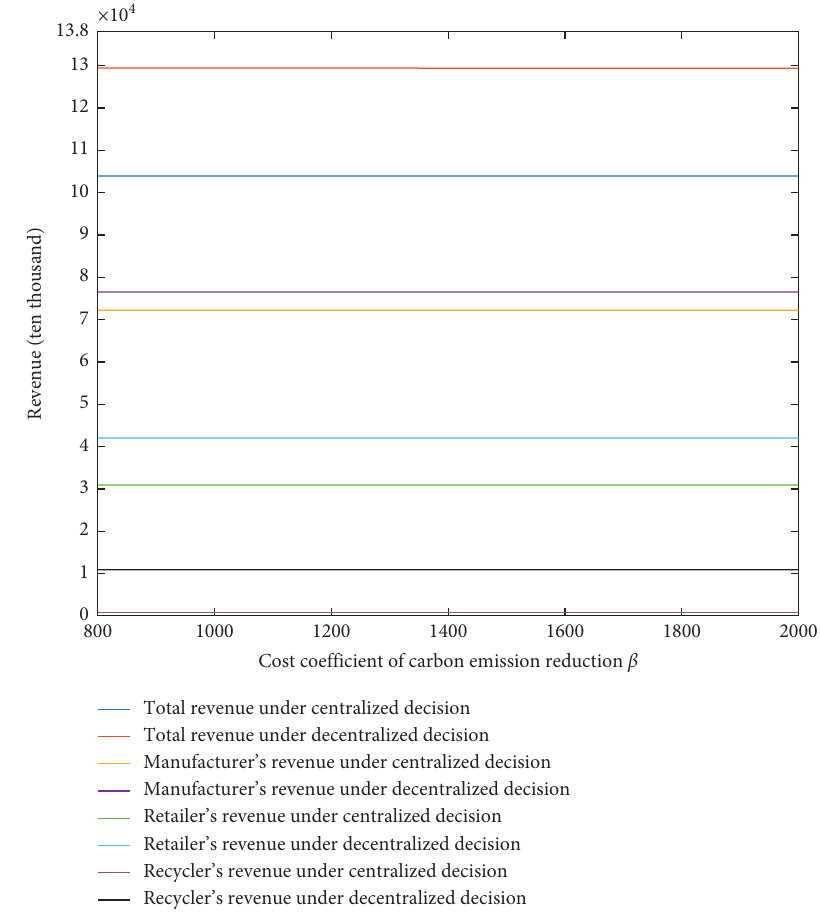
Figure 2: Effect of changes in the cost coefficient β of supplier carbon emission reduction on the total revenue of the supply chain under different decision-making